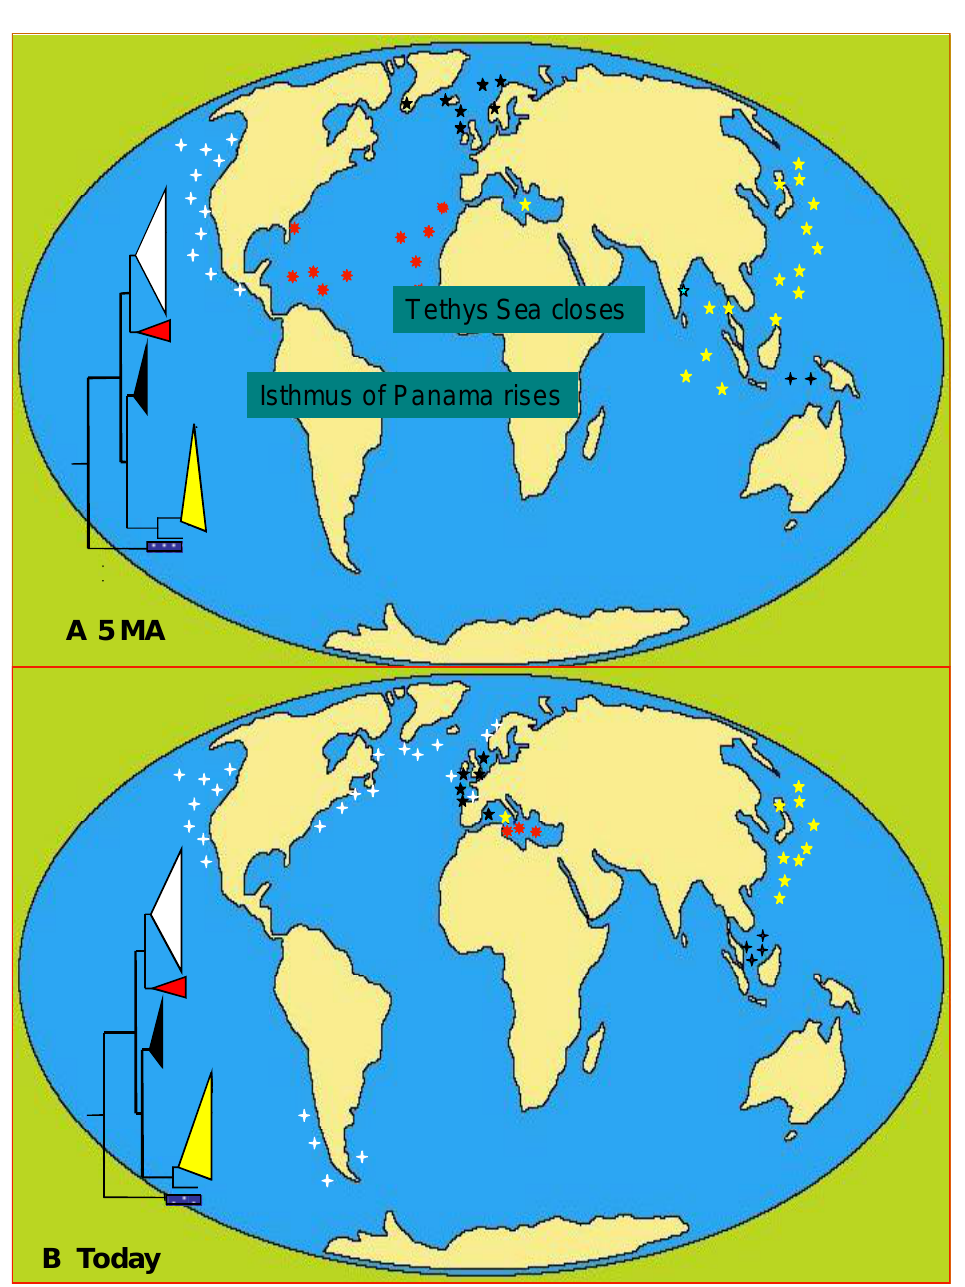
Figure 5. Phylogeographic representation of the distribution of geographic ribotypes in the Alexandrium tamarense species complex at 5 MA (a) and today (b) . Toxic Temperate Asian ribotype = yellow stars on map, yellow triangle in tree; Non-toxic Western European ribotype = black stars on map, black triangle on tree; North American ribotype = white pinnacles on map, white triangle on tree; Mediterranean ribotype = red starbursts on map red triangle on tree; Tropical Asian = black pinnacles on map, blue-dotted box on tree. Redrawn from [122] with updated modern